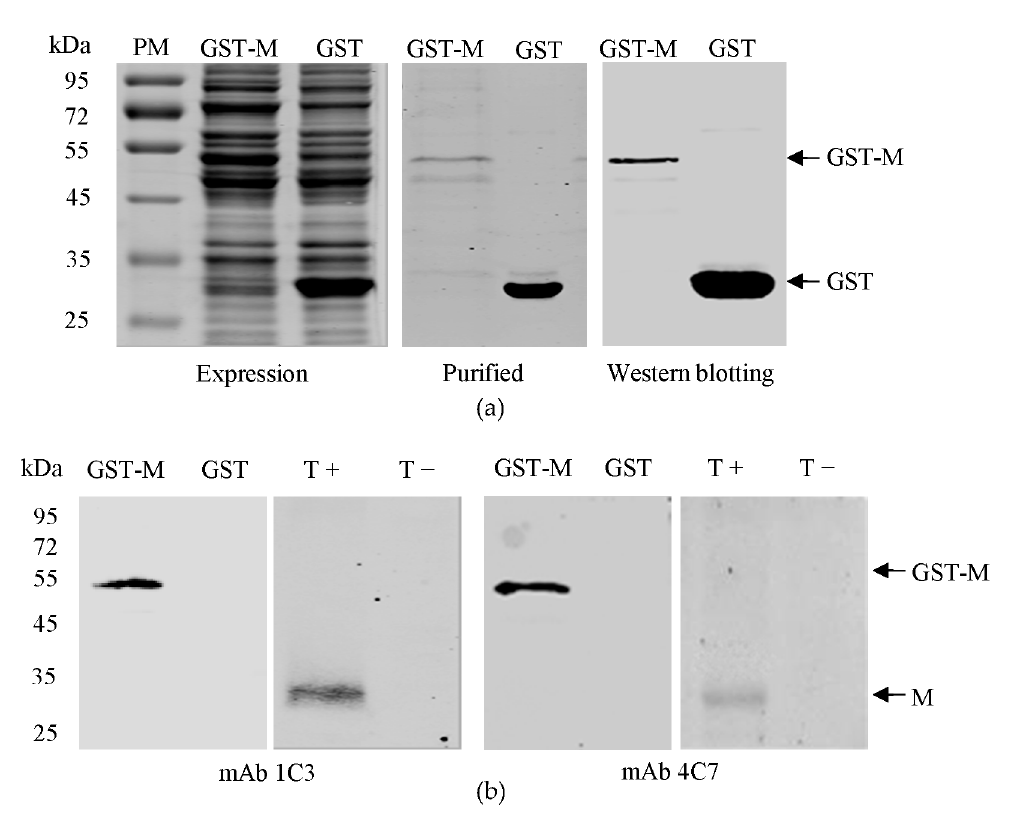
Figure 1. Preparation of monoclonal antibodies (mAbs) against the M protein of TGEV. ( a ) Expression and purification of GST-M protein. The proteins were detected after western blotting with a GST mAb; ( b ) Reactivity of the 1C3 and 4C7 mAbs with the GST-M protein and the TGEV M protein. PM represents protein marker. T+ represents the cell lysates of TGEV-infected porcine kidney 15 (PK-15) cells. T − represents the cell lysates of mock infected PK-15